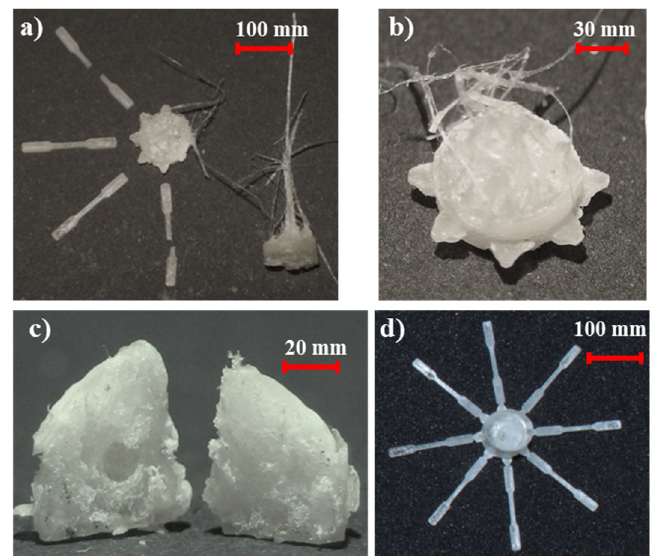
Figure 2. Polylactide (PLA) micromolded samples loaded with 10 wt-% of sodium carbonate ( a , b ), sodium bicarbonate ( c ) and sodium chloride ( d ). Processing amplitude, force and time parameters were in this case 24 µm, 300 N and 1.2 s, respectively.